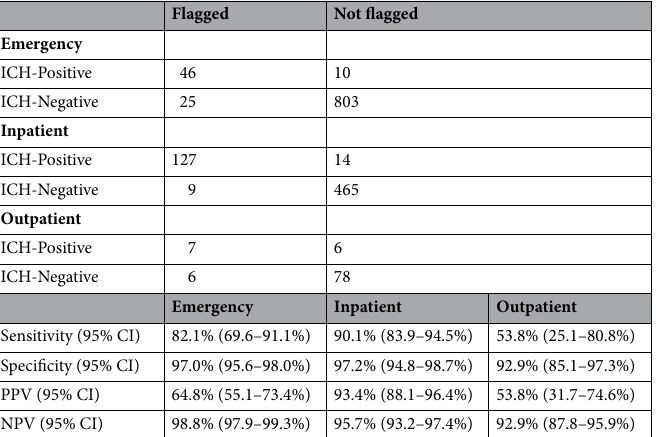
Table 1. Confusion matrix with calculated sensitivity, specificity, positive predictive value (PPV) and negative predictive value (NPV) of Aidoc ICH in emergency, inpatient, and outpatient CT head scans.